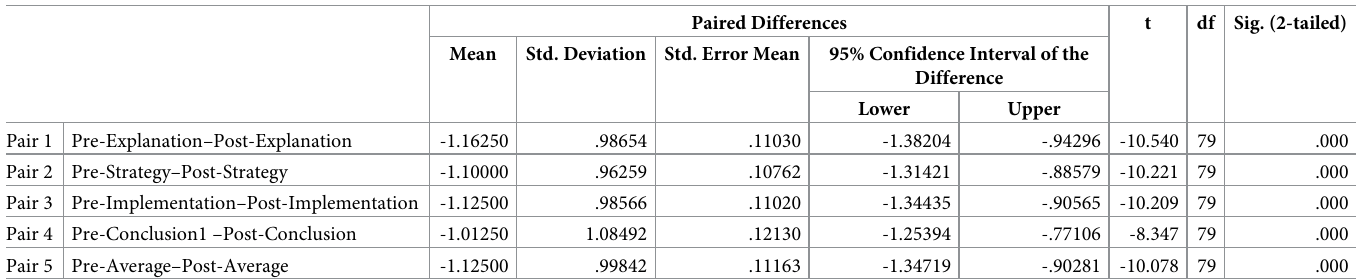
Table 6. Paired t-test